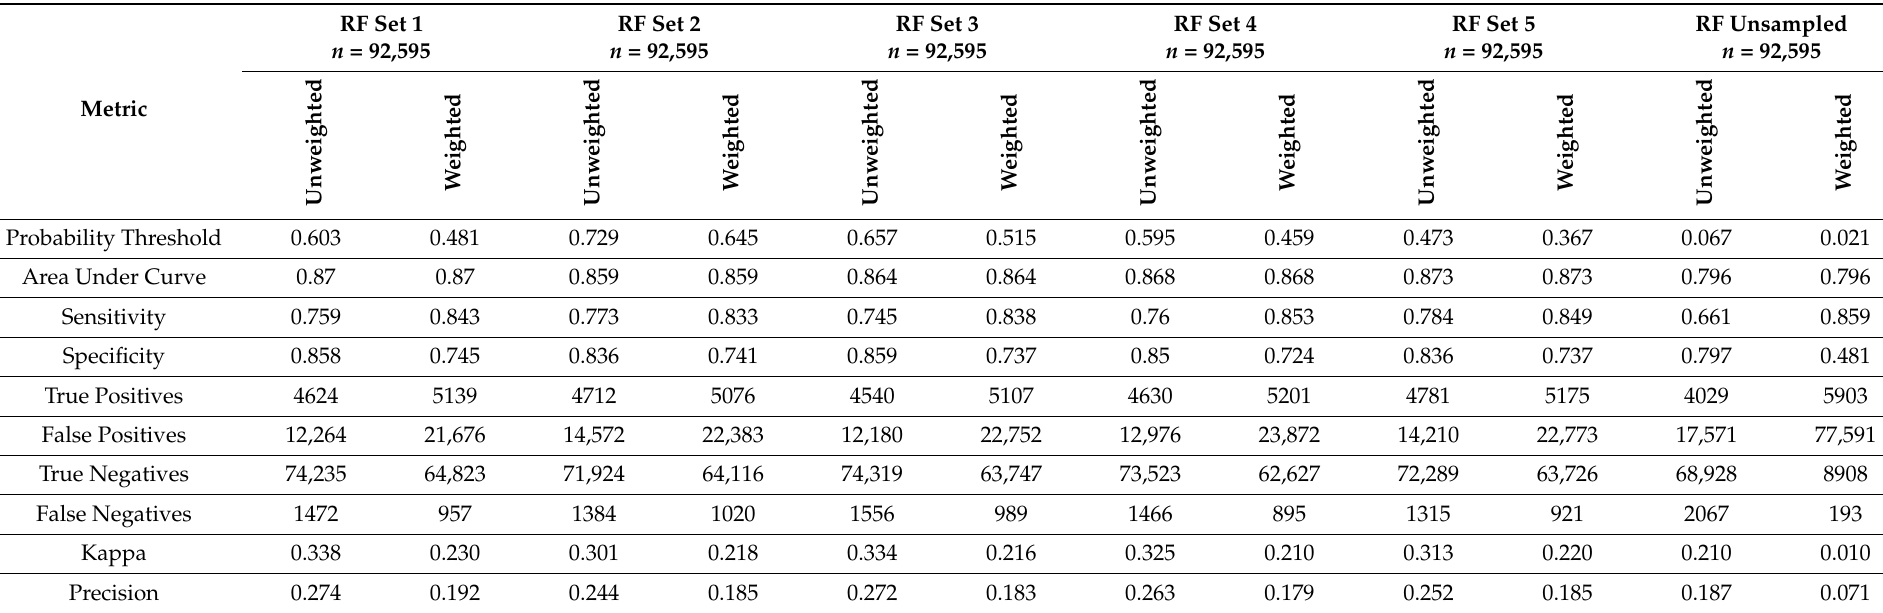
Table 4. Weighted and unweighted performance metrics for random forest models utilizing SMOTE datasets across 5 sampling strategies where weighted observations have a cost penalty applied (30) when extracting the optimal probability threshold and where precision is the proportion of correctly classified non-compliant